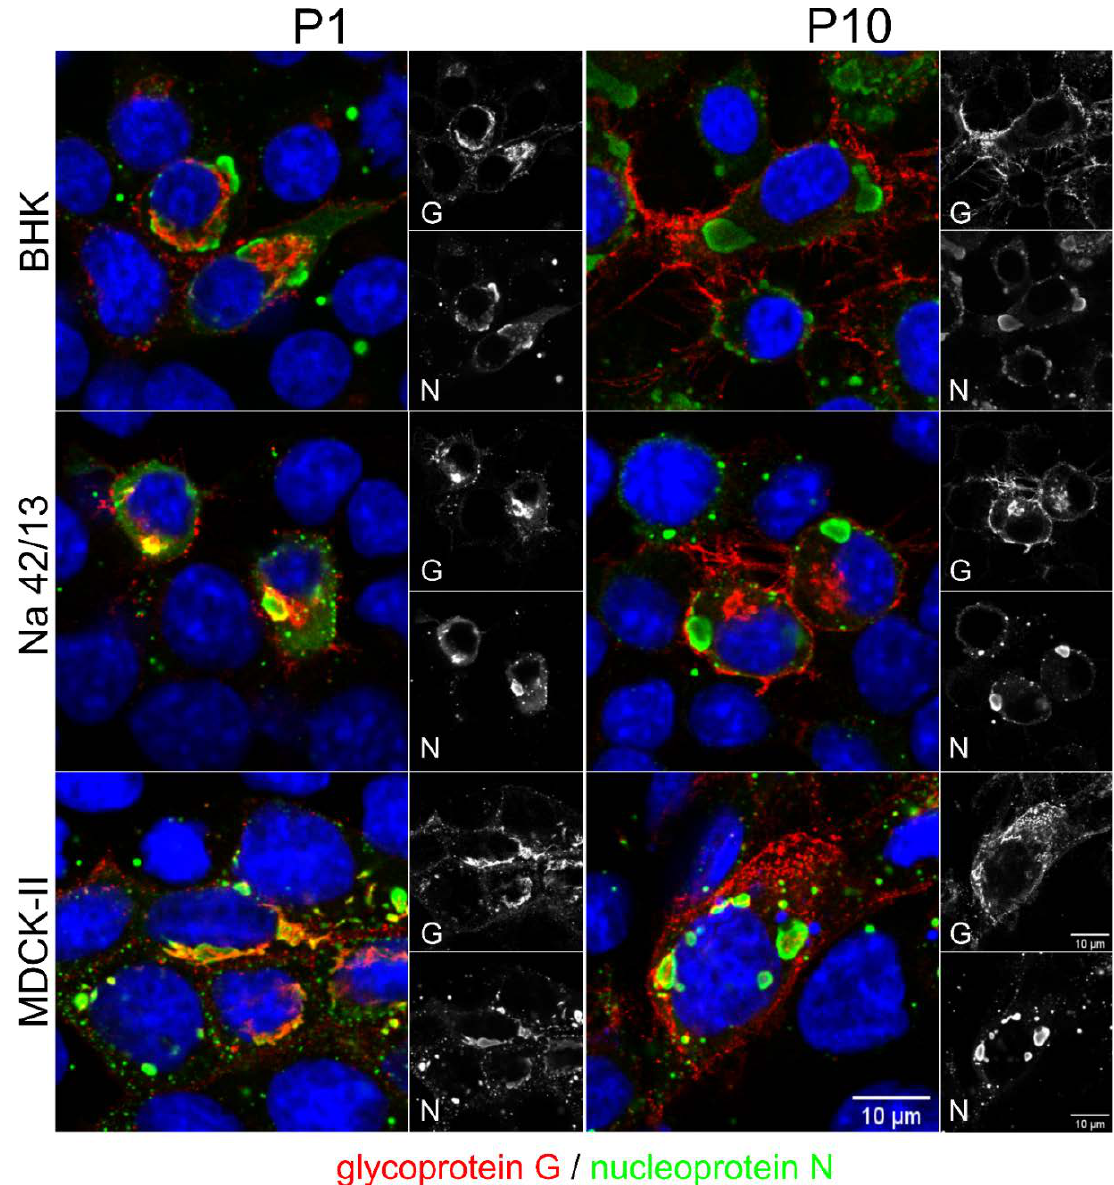
Figure 3. Early passages of rRABV Dog on BHK, Na 42/13, and MDCK-II cells underline an intracellular accumulation of glycoprotein G. Immunostaining of glycoprotein G (red) and nucleoprotein N (green) in cells infected with P1 and P10 viruses at 1 dpi. The distribution of G changes from a perinuclear localization in cells infected with P1 viruses to a more plasma membrane-associated localization in cells infected with P10 viruses. Shown are representative images for the indicated cell lines. Blue: Hoechst 33342.